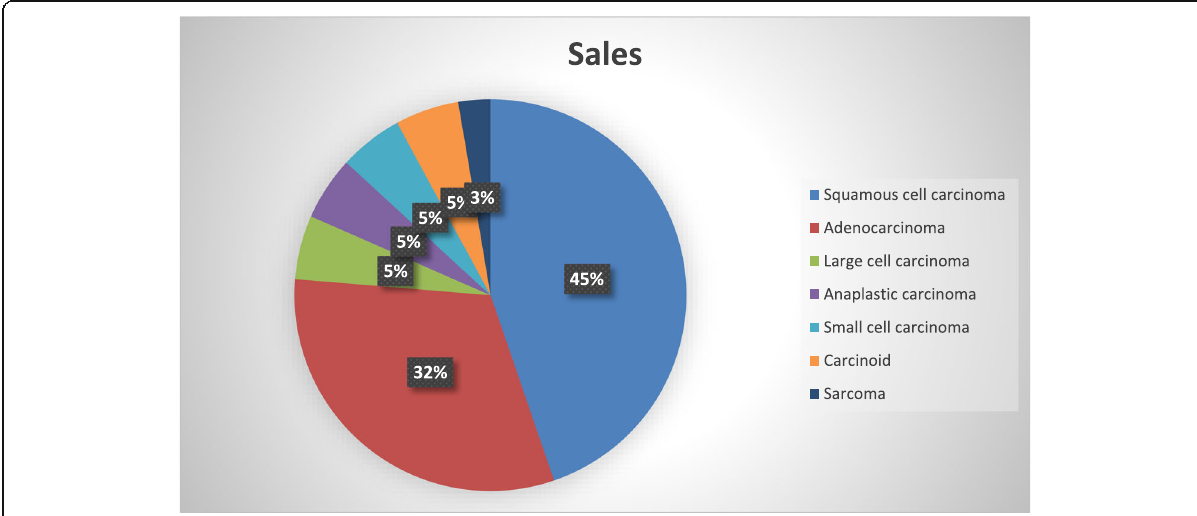
Table 1 The size of the lesions Location Morphology Direct invasion Pathological type Mean Size (cm) Central Peripheral Cavitary Solid Pleura Mediastinum Chest wall Squamous cell carcinoma (17